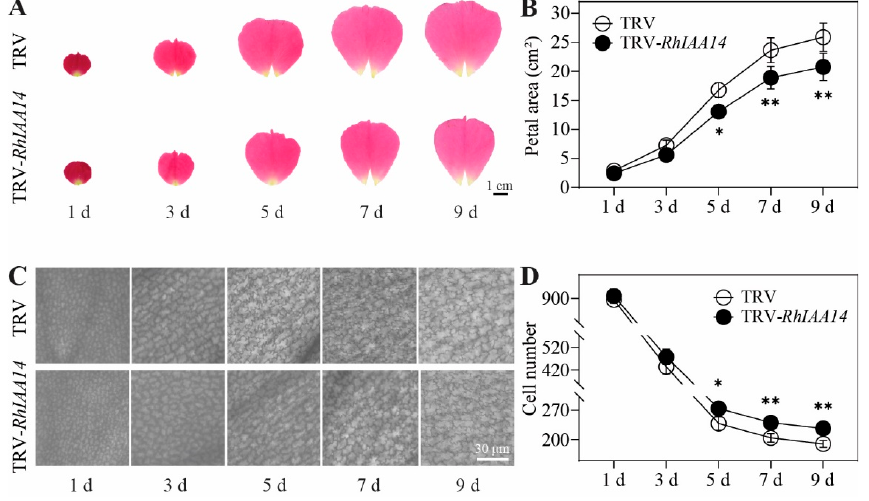
Figure 5. Petal and AbE cell phenotypes of silenced RhIAA14 . ( A ) Image of flattened petals. TRV, empty vector; TRV- RhIAA14 , TRV containing a fragment of RhIAA14 . The images were taken every other day. ( B ) Sizes of RhIAA14 -silenced petals. Bar = 1 cm. ( C ) Image of AbE cells at the center part of petals. ( D ) AbE cell density of RhIAA14 -silenced petals. The cells were counted in visual fields of 300 × 300 µ m. Bar = 30 μ m. The results are the mean of three biological replicates ± SD, and the asterisks indicate significant differences, in accordance with Mann–Whitney U-test (* p < 0.05; ** p < 0.01).